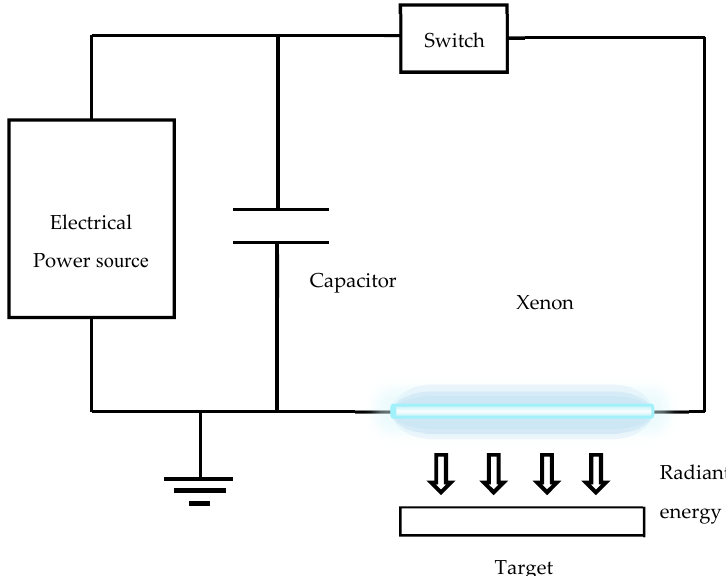
Figure 5. PL generation system. PL generation system consists of an electrical power source from where electric energy enters the capacitors, which accumulate the energy and get discharged into high-intensity light